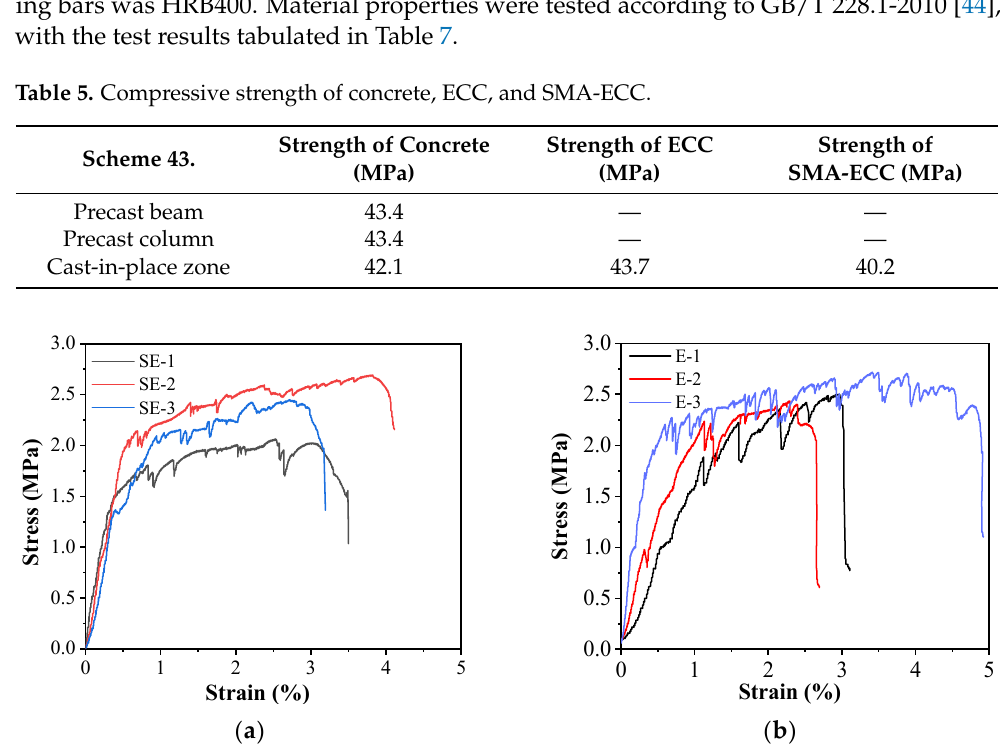
Figure 3. The tensile stress–strain curves of materials. ( a ) SMA-ECC; ( b ) ECC. Table 6. Tensile test results of ECC and